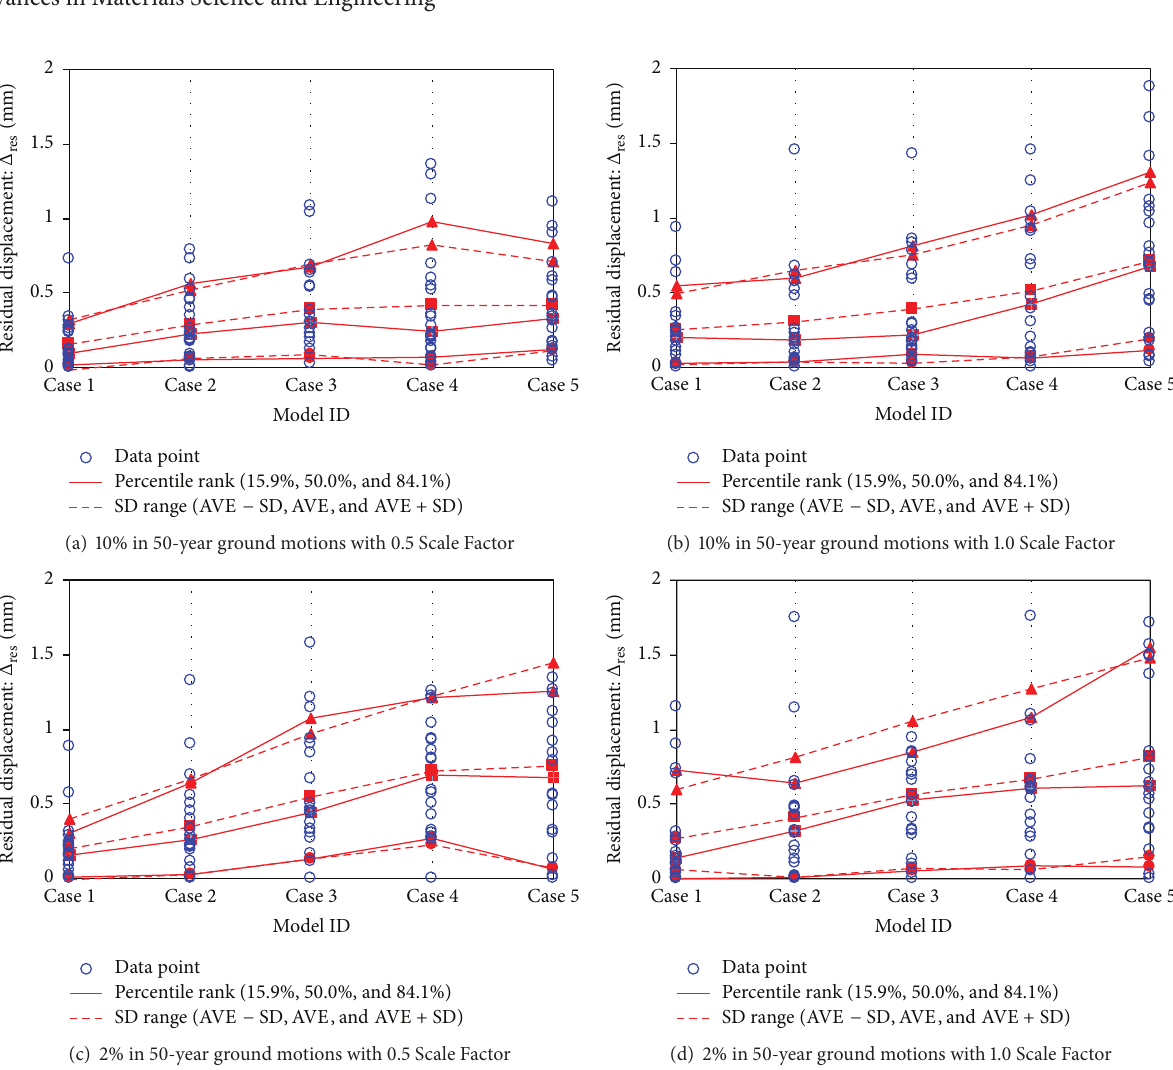
mainly investigated through nonlinear dynamic time-history analyses. More conclusions are as